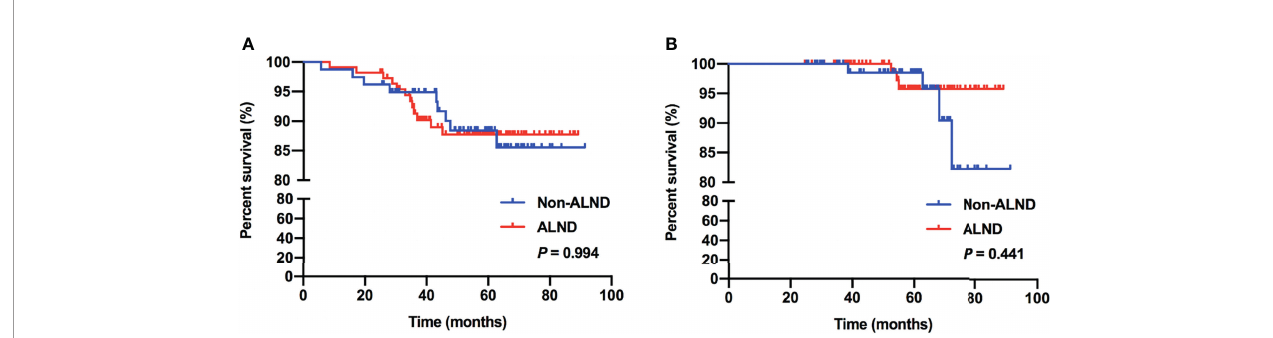
FIGURE 1 | RFS (A) and OS (B) between the non-ALND and ALND groups.